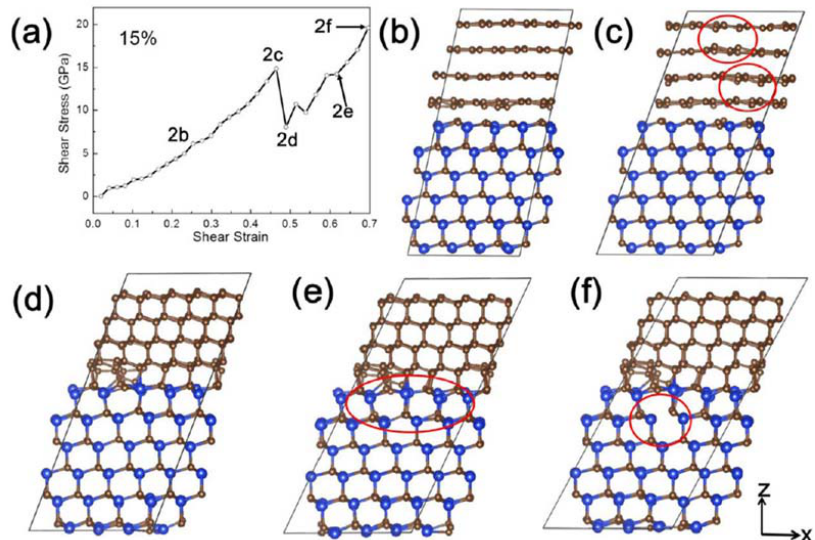
Figure 12. ( a ) Shear stress–strain curve of SiC and carbon integrated system at 15% pre-compressed rate along the z-axis. ( b – f ) Snapshots of structures of the integrated system corresponding to the indications in Figure 12a. ( b , c ) A shift of carbon atoms to the neighboring carbon layer. ( d , e ) Formation of diamond structured phase by new bond formation of SiC and carbon, and dislocation in SiC. ( f ) Breakage of bonding in n ‐ SiC at the shear strain of 0.696. Reproduced with permission from [69]. Copyright 2022 Elsevier.